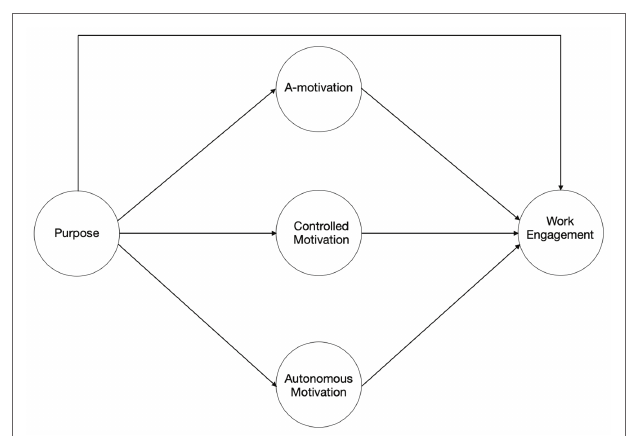
FIGURE 1 | Research model for Study 1. The research model portrays the multiple mediation model of the present study, testing the hypothesis that purpose associates positively with work engagement through autonomous motivation and negatively through controlled motivation and